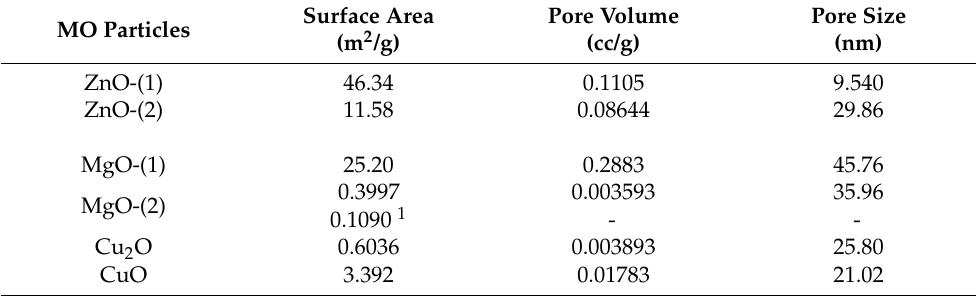
Table 2. Surface characteristics of metal oxide (MO) particles.